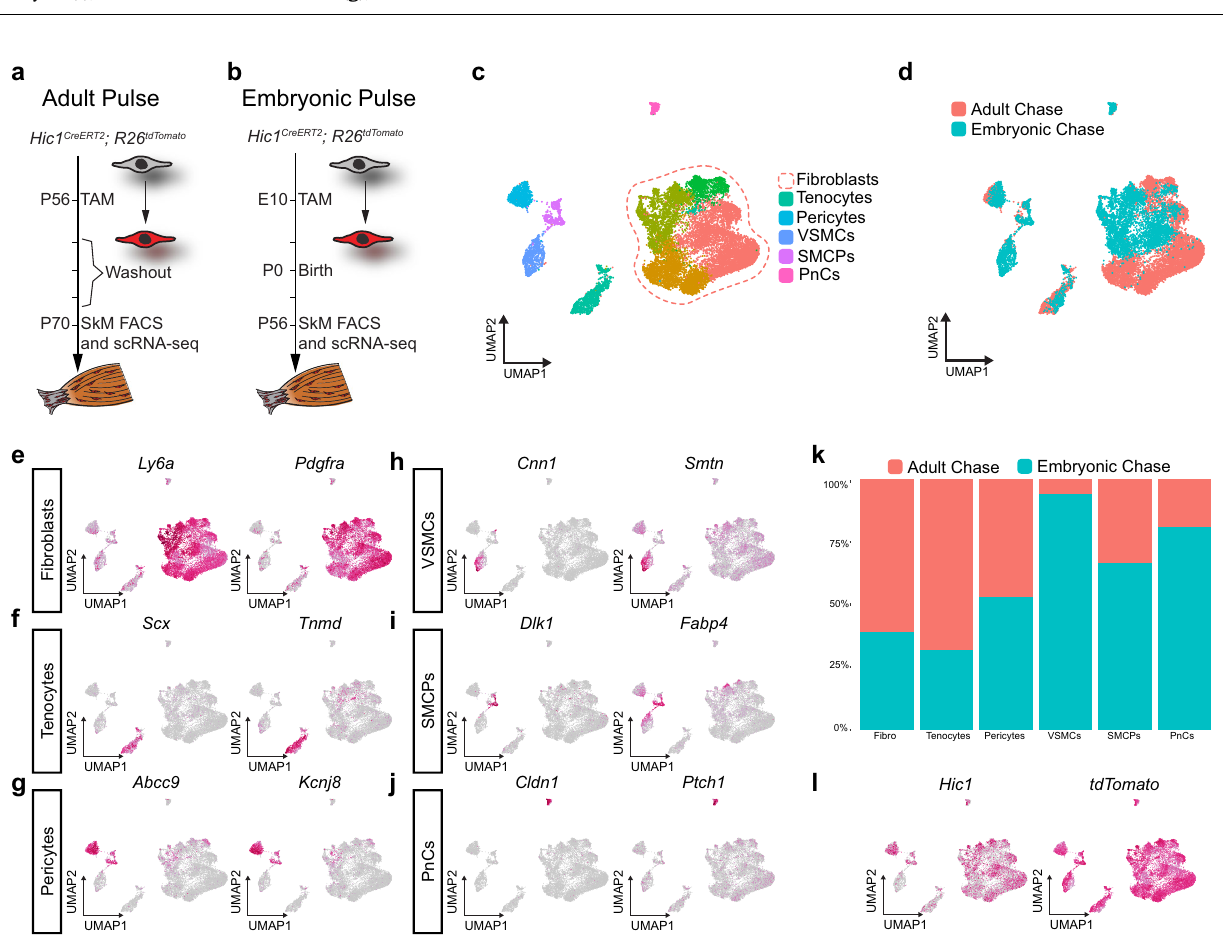
Fig. 7 | Embryonic Hic1 + MPs give rise to distinct populations of adult stromal cells. a Schematic representation of strategy employed for lineage tracing embryonic Hic1 + MPs into adulthood. b UMAP coloured by cluster of scRNA-seq data from sorted tdTomato + cells isolated from the TA muscle of lineage-traced Hic1 CreERT2 ;R26 tdTomato mice. c HeatmapofscRNA-seqdatashowingenrichedgenes within each cluster. d – i Representative immuno fl uorescence images and violin plots of each cell population identi fi ed through lineage tracing performed from E10 until P56 on Hic1 CreERT2 ; R26 tdTomato mice. TdTomato + populations persist as cells from the following lineages: fi broblasts ( d ); tenocytes and myotenocytes ( e ); pericytes ( f ); vascular smooth muscle cells ( g ); smooth muscle cell